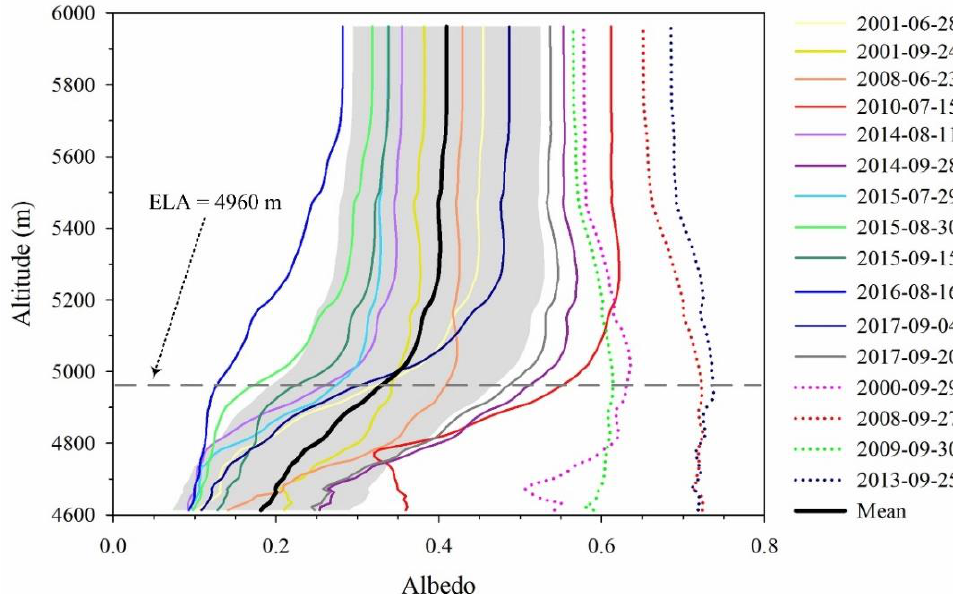
Figure 5. The change in the surface albedo with altitude over the Chhota Shigri glacier. The albedo curves are labeled with the acquisition dates (YYYY-MM-DD) of the different Landsat images. Note that the thick solid black line (mean) represents the average value of all the solid-line data in this figure, and the standard deviation is also shown as shaded envelopes.